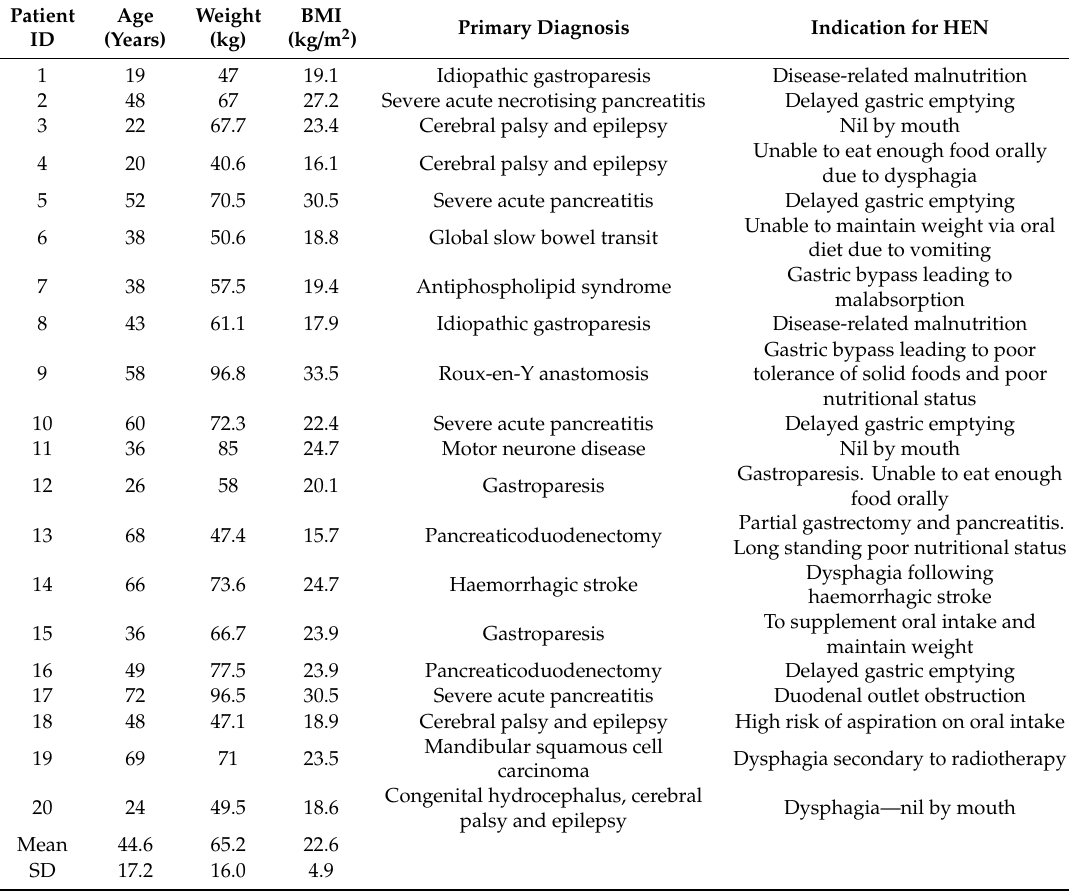
Table 2. Baseline patient characteristics: age (years), weight (kg), BMI (kg / m 2 ), primary diagnosis and indication for HEN (Home Enteral Nutrition).